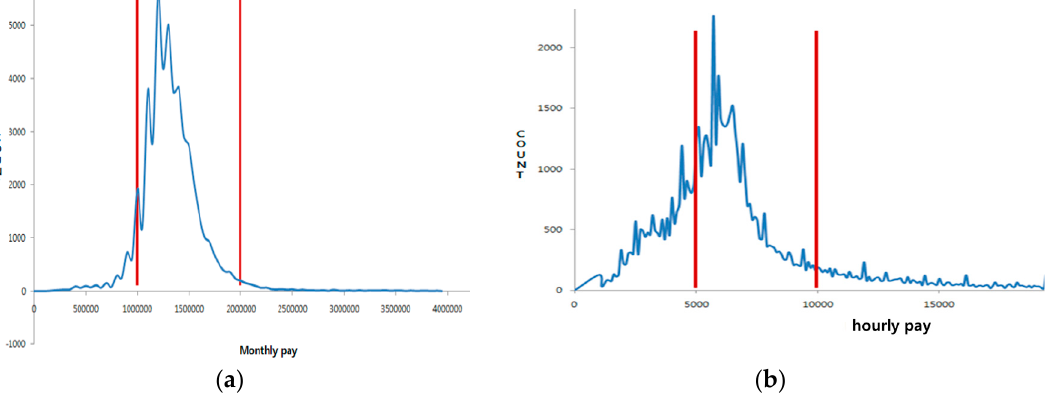
Table 1. Staff of residential care and home care facilities.